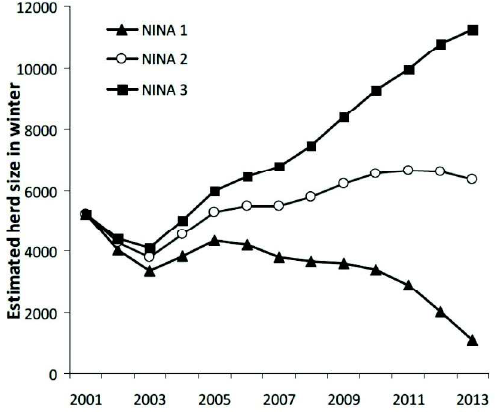
Figure 5. Estimated wild reindeer winter herd size in Hardangervidda 2001 – 2013 based upon the herd size estimated in 2001 (Lund, 2001), harvest data (Statistics Norway), recruitment and female composition data re- ported in Solberg et al. (2012) and NINA reports (see text to Fig. 4). Mortality rates are set to 5 % of the herd after the harvest. The models represent three scenarios where recruitment rates (calves per 100 females 1 yr+) are based upon 1) absence of yearlings, i.e. the recruitment rate estimate calves per 100 female 2 yr+ (NINA 1), 10 % yearlings (NINA 2) and 15 % yearlings (NINA 3) in the 1 yr+ female groups (see the Methods